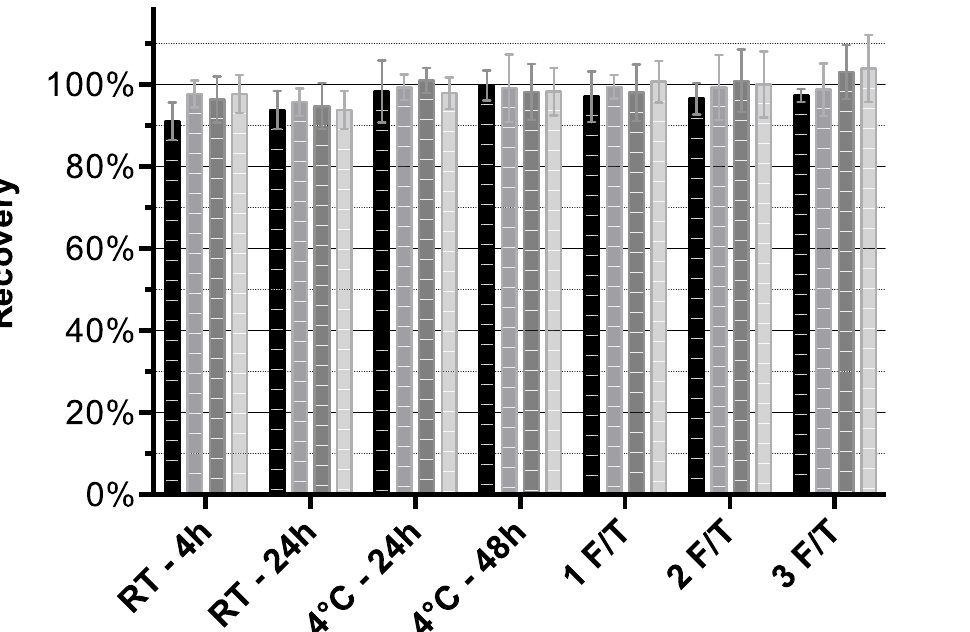
Fig 2. Stability experiments. Stability of CTSD, ICAM1, OLFM4, and THBS1 in serum stored at room temperature (RT), 4˚C or 1 up to 3 freeze and thaw (F/T) cycles, respectively.Shownare the mean (SD; error bars) measured protein concentrations (as a percentage of the originalvalues)in 5 different samples.